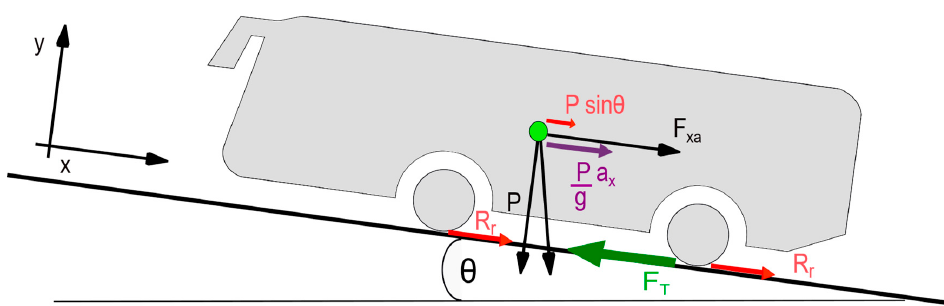
Figure 6. Physical factors required to model and design the propulsion system.